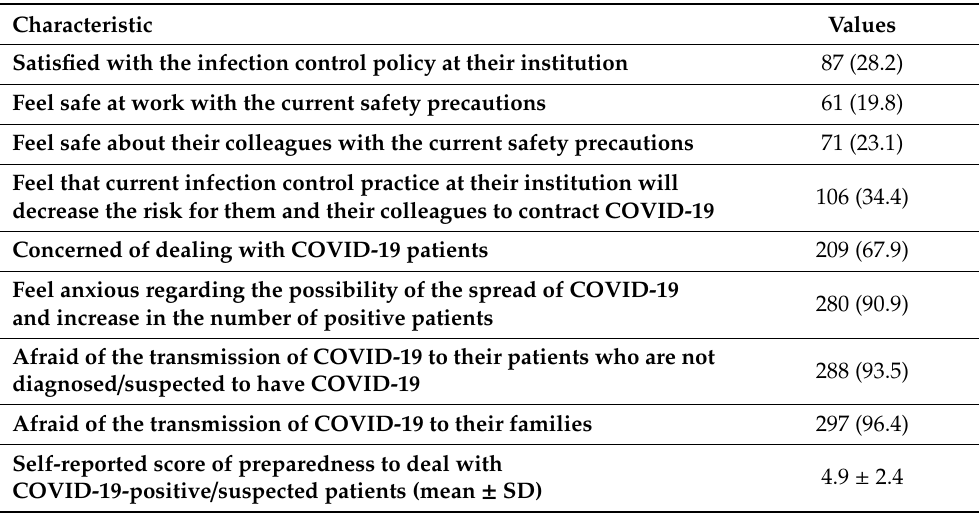
Table 2. Psychological interactions, institutional support, and self-reported preparedness for dealing with COVID-19 patients among frontline